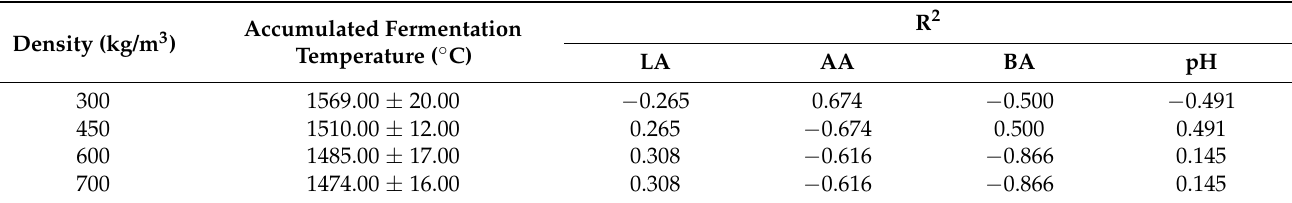
Table 6. Correlation between the accumulated temperature of whole-plant corn silage fermentation and